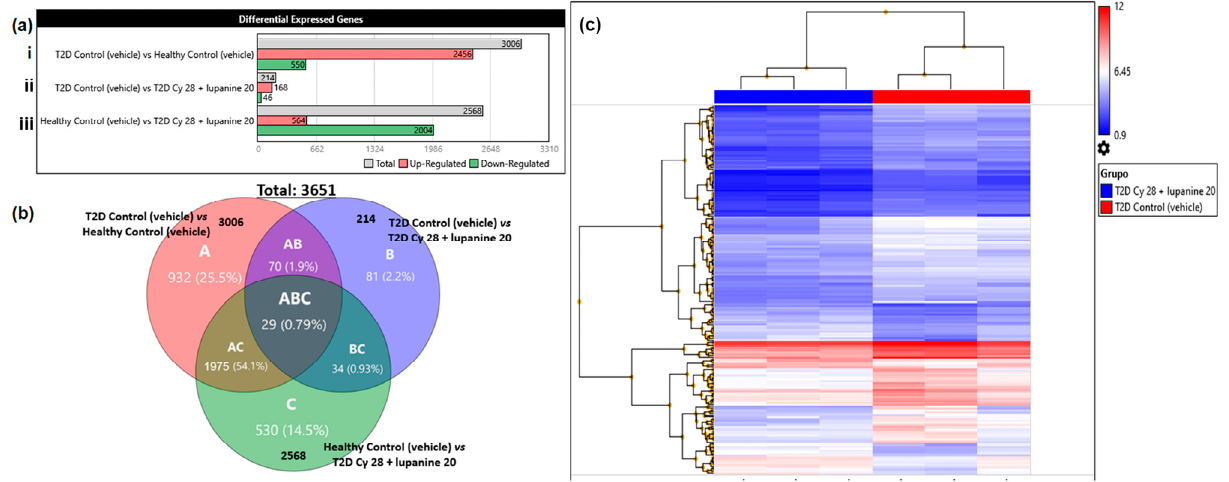
Figure 4. Overview of upregulated and downregulated genes in the experimental groups. ( a ) Dif- ferentially expressed genes comparing ( a , i ) the T2D control vs. healthy control, ( a , ii ) T2D control vs. T2D C γ + lupanine, and ( a , iii ) healthy control vs. T2D C γ + lupanine ( b ) Venn diagram depicting the number of DEGs among the experimental groups. ( c ) Hierarchical clustering analysis of comparison between T2D C γ + lupanine group in blue color and the T2D untreated group in red color. Table 2. Top 10 differentially regulated coding genes. T2D Control and T2D Treated with C γ + Lupanine Upregulated Downregulated Gene Fold Change Gene Fold Change Chac1